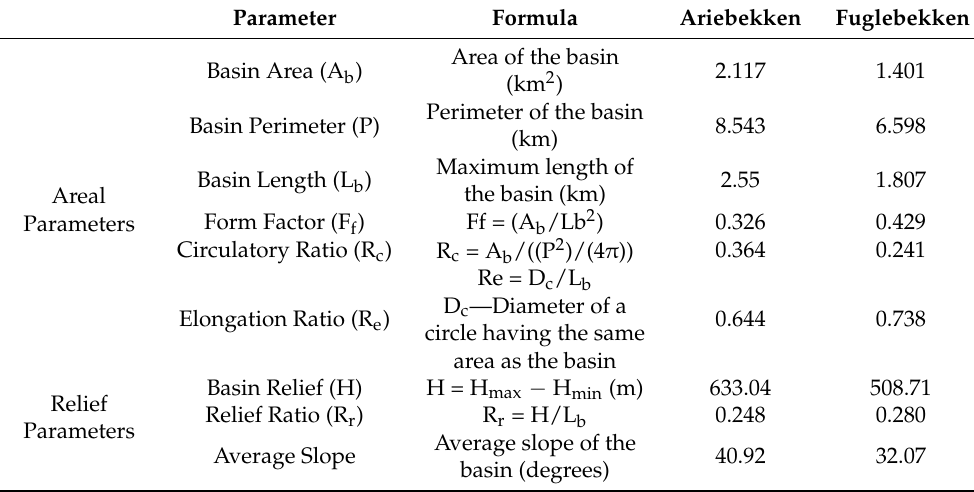
Table 1. Morphometric parameters of Ariebekken and